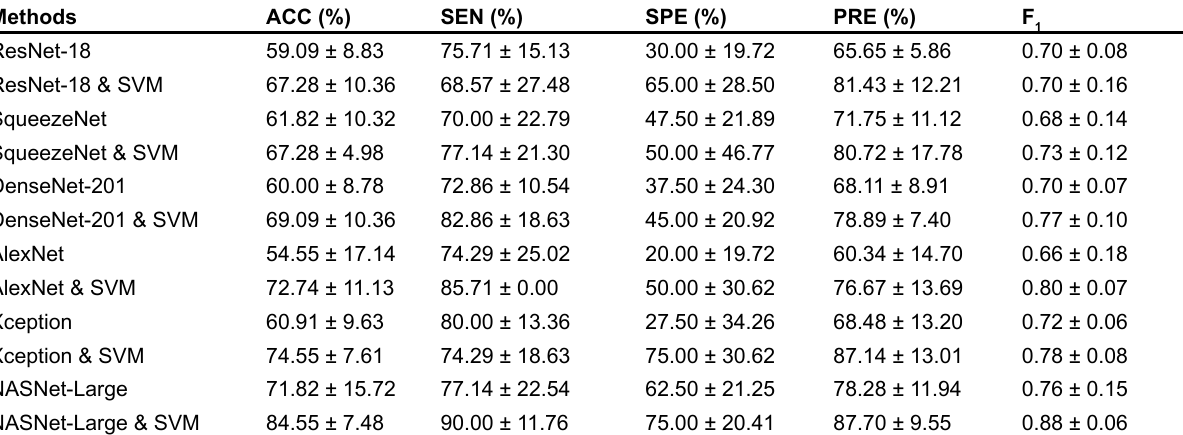
Figure 1. Training and testing procedures. A. Diagram of main steps for building an SVM classifier with extracted CNN features of training IHC and B. testing the trained SVM classifier in predicting the survival time given a test